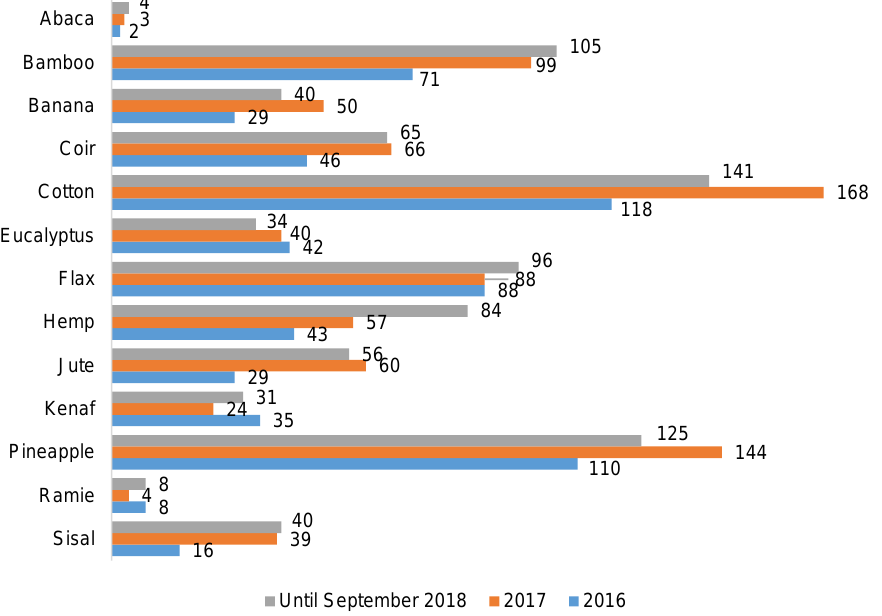
Figure 4. Number of research articles about natural fibres on composites. Cross-reference search criteria (by search term: “fibre name” composite and by title or keyword: “fibre name”, including name alternatives).